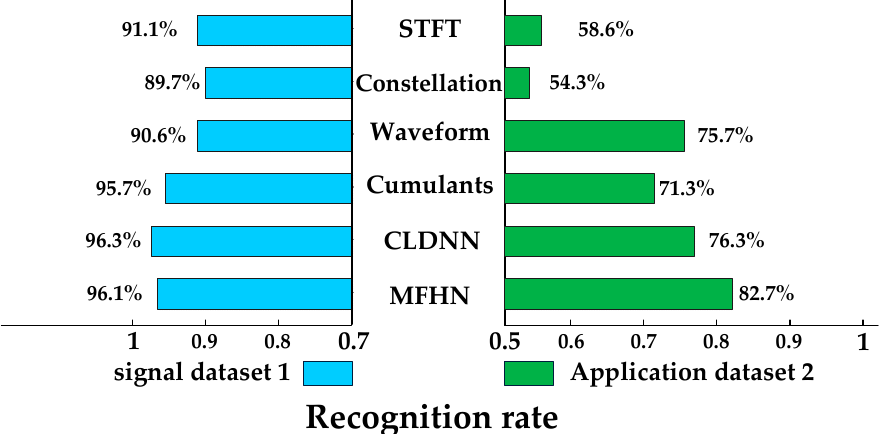
Figure 14. Comprehensive performance comparison with other methods, Results on dataset 1 mean that the signal parameters to be recognized are consistent with those of the training set. Results on dataset 1 mean that the signal parameters to be recognized are inconsistent with those of the training set.